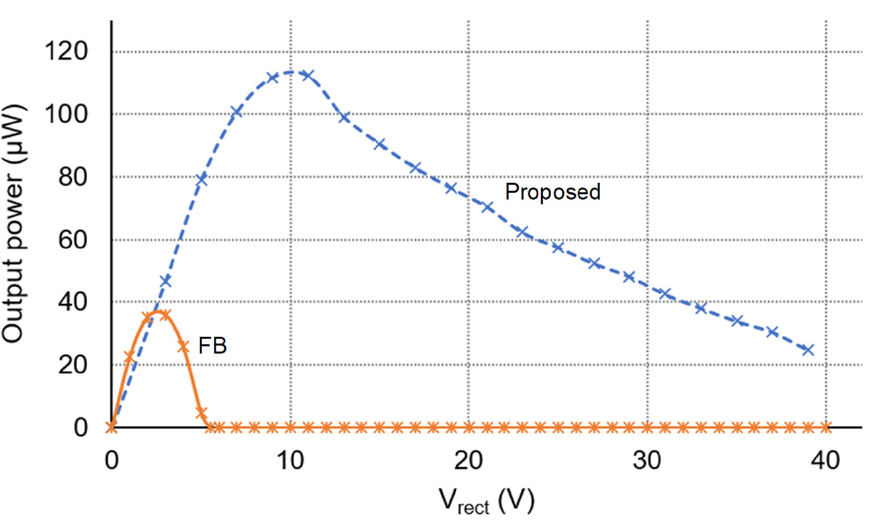
Figure 15. Power delivered to the load for the full-bridge (FB) circuit and the proposed circuit.